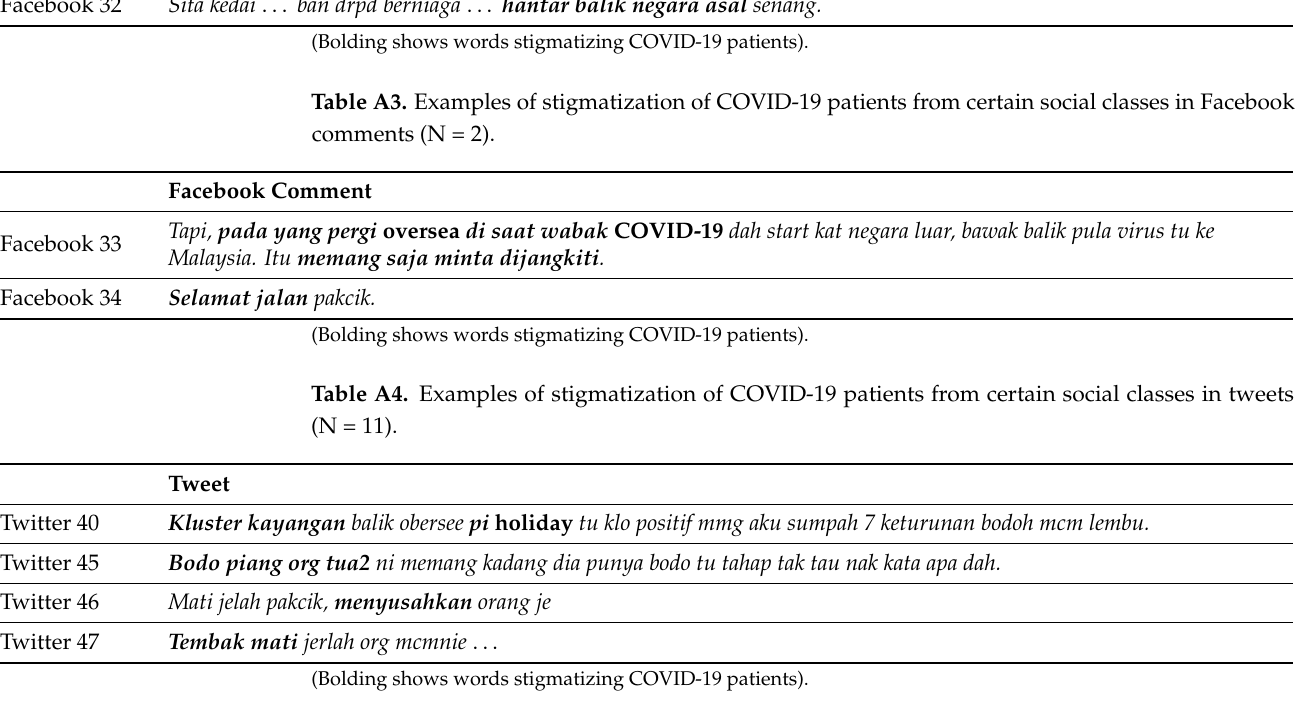
Table A5. Examples of ethnicity-related stigmatization of COVID-19 patients in tweets (N = 17). Tweet